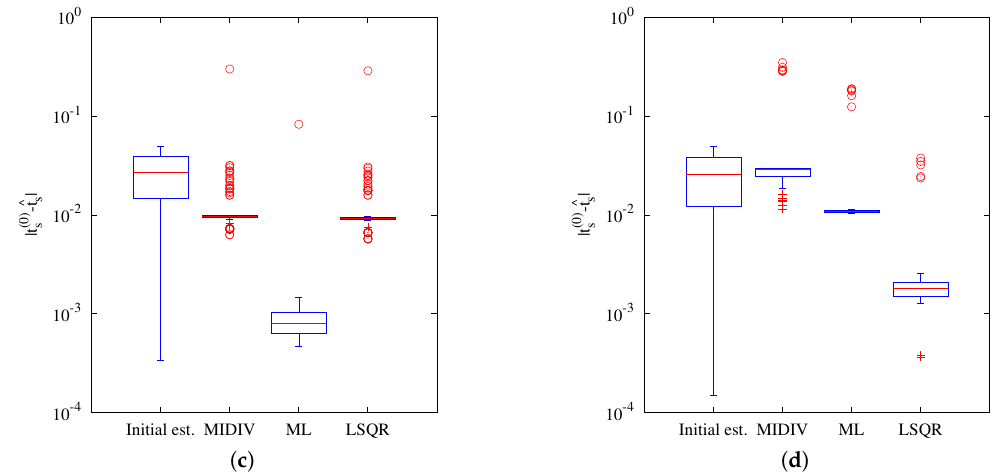
Figure 3. Descriptive statistics of the residuals of initial estimates and estimations of the methods. Residuals of initial estimates where computed as the absolute value of the difference between the randomized initial estimate and the ground truth. ( a ) Without noise; ( b ) Noise Case I (NCI); ( c ) NCII; ( d )